Question: Give a one-sentence summary of this figure.
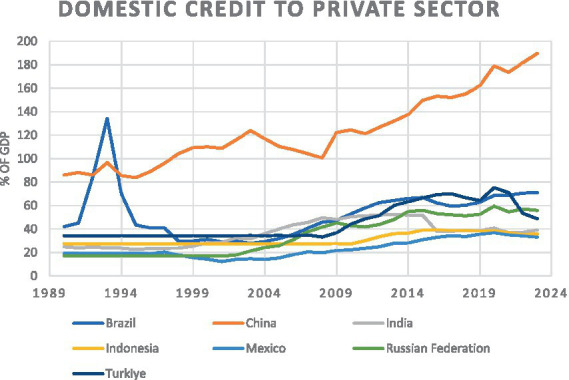
Answer: Annual trend of DCPS in E7 nations during the study span.